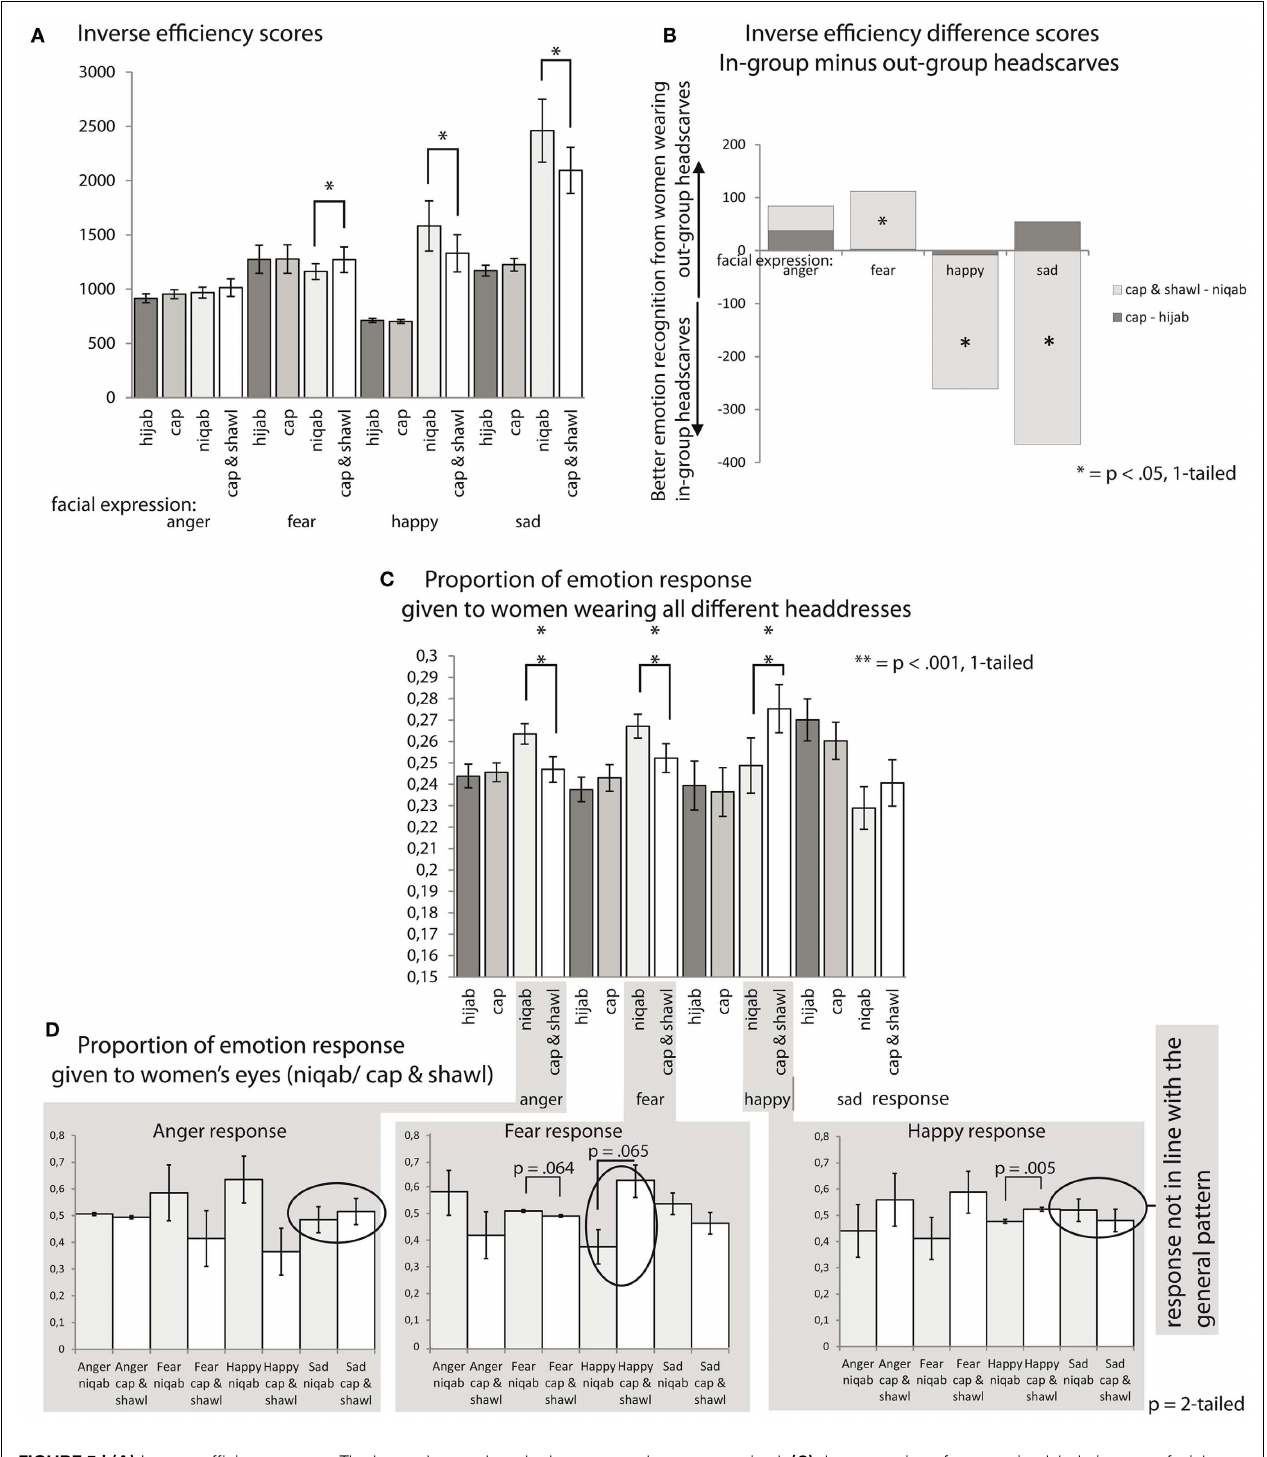
FIGURE 5 | (A) Inverse efficiency scores.The lower the number, the better the performance. Fear was better recognized from women wearing a niq ¯ ab vs. a cap and a shawl. Happiness and sadness were better recognized from women wearing a cap and a shawl than from women wearing a niq ¯ ab. (B) The graph shows difference scores from the “in-group minus out-group” inverse efficiency scores.The upper part of the graph shows conditions where the out-group was better recognized; the lower part where the in-group was